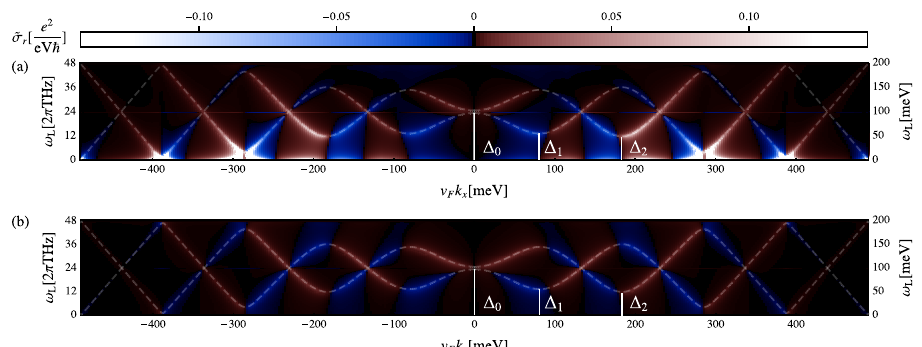
Fig. 4 Momentum-resolved optical conductivity of light-driven graphene. The momentum-resolved contributions to the optical conductivity of driven graphene along the k x ( a ) and k y ( b ) momentum directions. The driving frequency is ω d = 2 π × 48 THz ≈ 200 meV and the fi eld strength is E d = 34 MV m − 1 . For these parameters the gap at the Dirac point roughly matches half the driving frequency such that Δ band energy differences Δ ϵ ( k ) and ω d − Δ ϵ ( k ) (See Supplementary